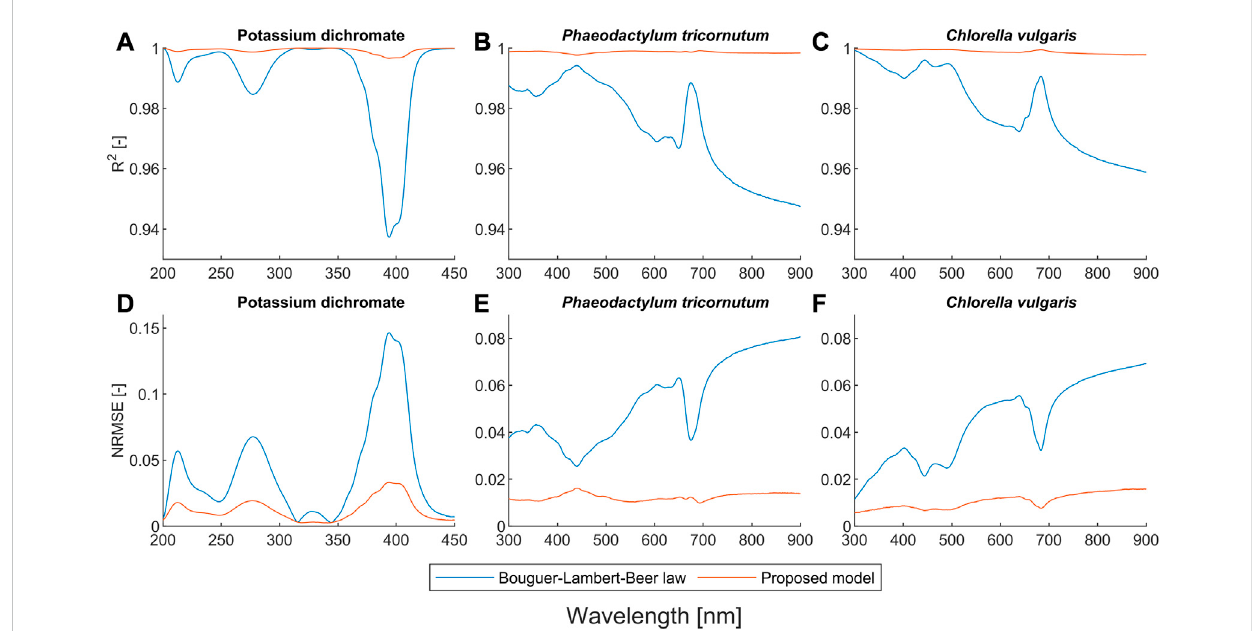
FIGURE 1 Quantitative comparison of the Bouguer-Lambert-Beer law and the proposed model in terms of R 2 and NRMSE for the potassium dichromate solutions and the microalgae